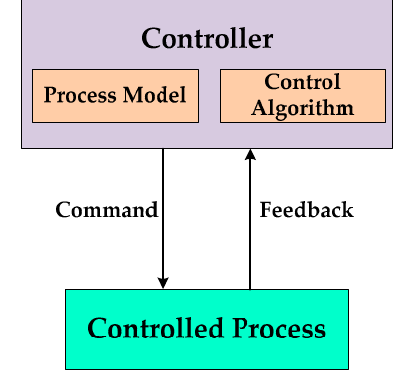
Figure 4. Multi-level control process.